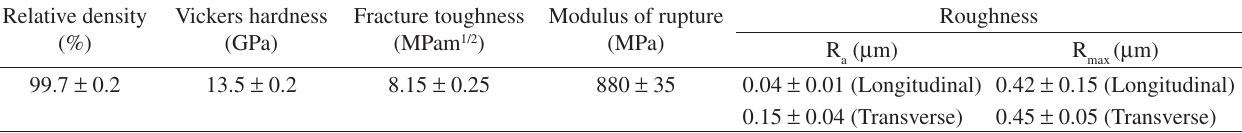
Table 1. Properties of the 3Y-TZP sintered samples. Relative density